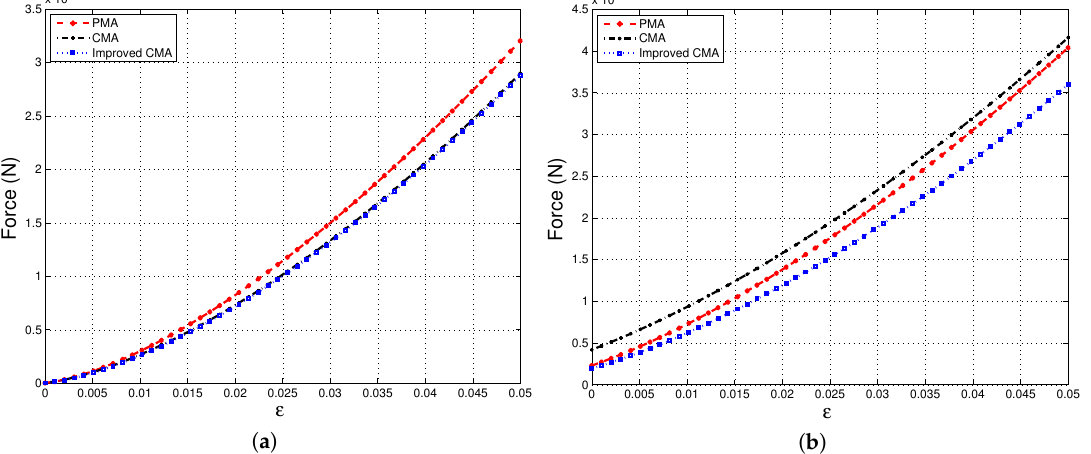
Figure 4. Compaction force versus strain, ε , under different thermal gradients applied at: − T w = 40 K ; ( b ) T w − T w = 1000 K ( a ) T w 2 2 1 1